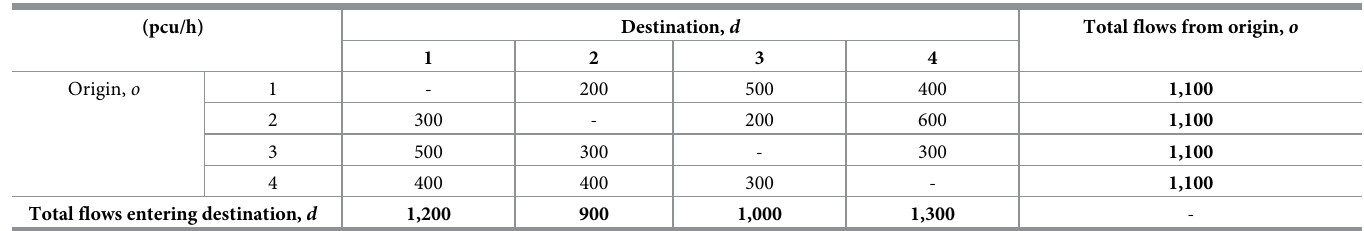
individual intersections given in [25, 27]. Also, z in Eq (32) is the set of users’ given o ; d ; h o ; d W d ; o ; hd ; o numerical weightings ( ¼ ) for two opposite inbound and outbound green bandwidths W o ; d ; ho ; d in the optimization process according to their relative importance. This BMILP problem can be solved by a standard branch-and-bound routine. A numerical example with four signalized intersections and four OD pairs is used to demonstrate the proposed design method in next section. Lane markings and signal timings can be optimized in a combined manner to generate both an efficient network and effective traffic signal settings. Assigned lane flows are optimized to satisfy the requirements for flow conservation.